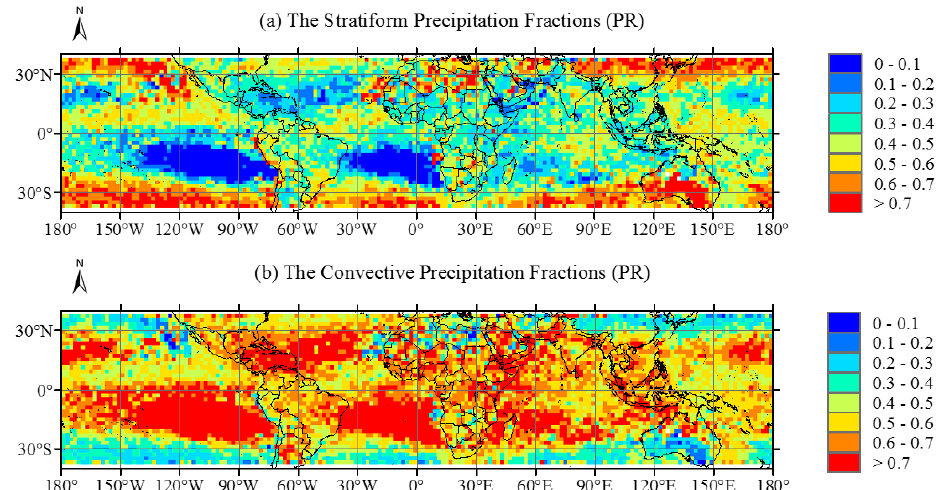
Figure 4. Global distribution of the fractions for: ( a ) stratiform; and ( b ) convective precipitation in the total precipitation volume captured by TRMM PR. All data are resampled to a spatial resolution of 2° × 2° and the fraction is calculated as the ratio between the accumulated stratiform/convective precipitation volume and the total precipitation volume.